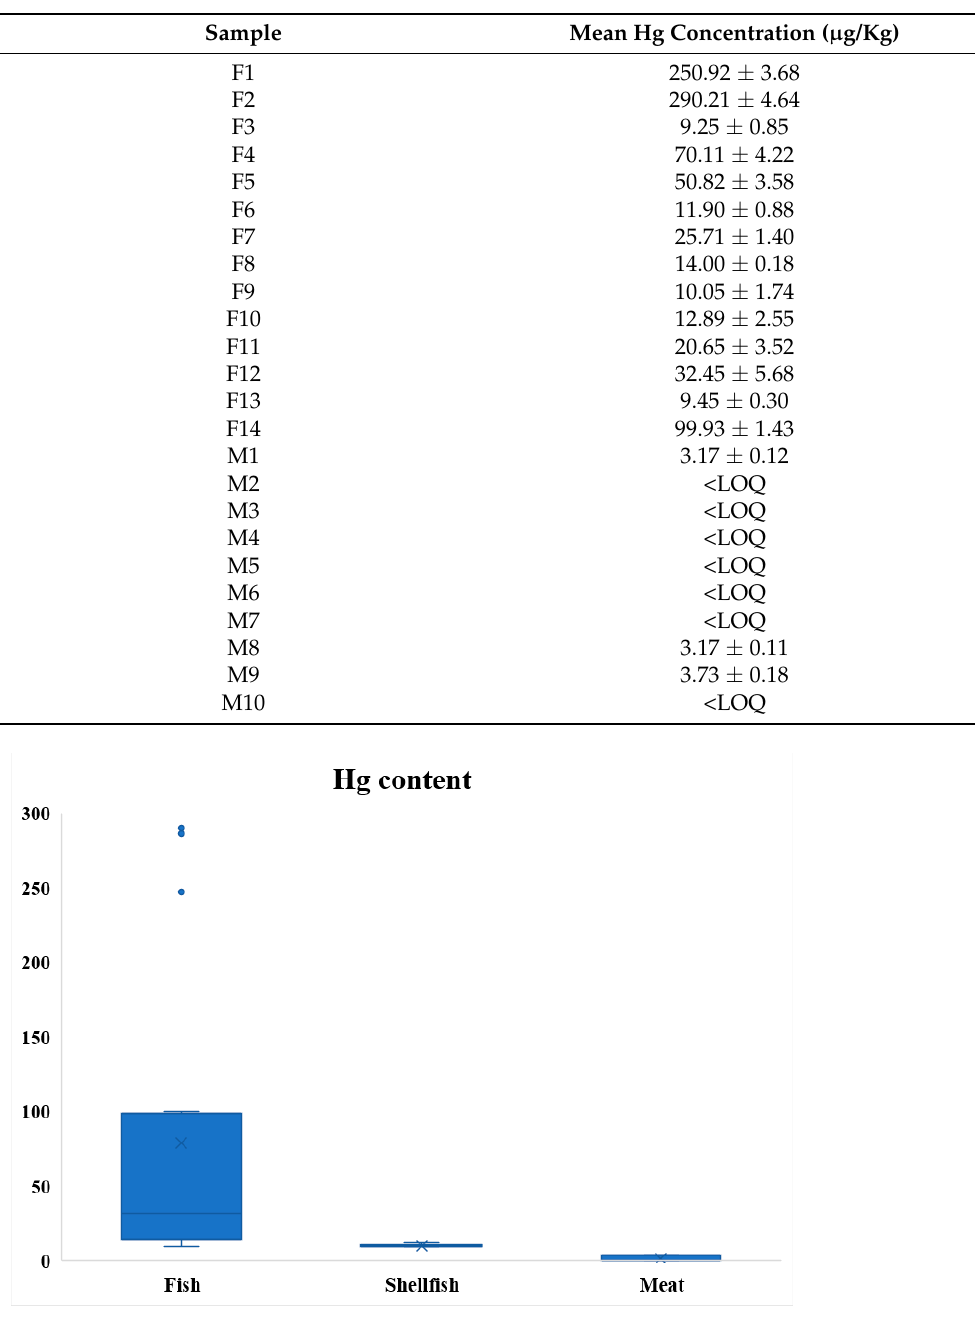
Table 2. Mean concentration levels of mercury expressed as µ g/Kg.